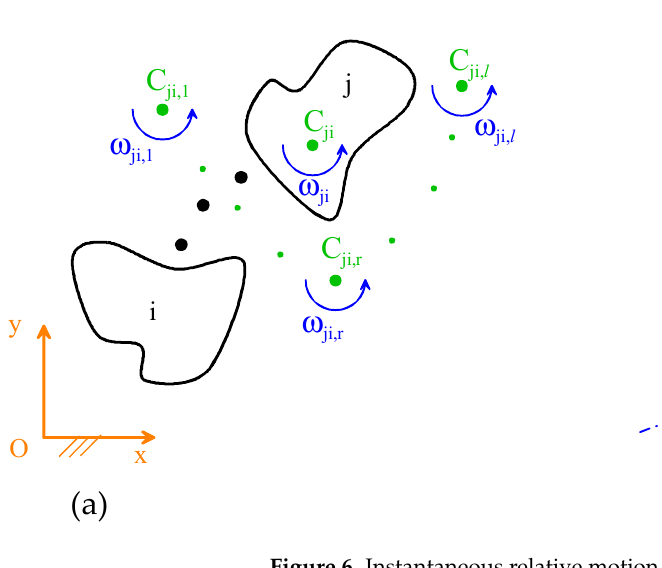
Figure 6. Instantaneous relative motion between two links, j and i, of an l -DOF PM ( C ji,r denotes the IC of this relative motion in the r-th single-DOF PM) when ( a ) C ji,r is a finite point (rotation around C ji,r ), and ( b ) C ji,r is a point at infinity located by the unit vector u ji,r (translation with the direction of the unit vector t ji,r ).